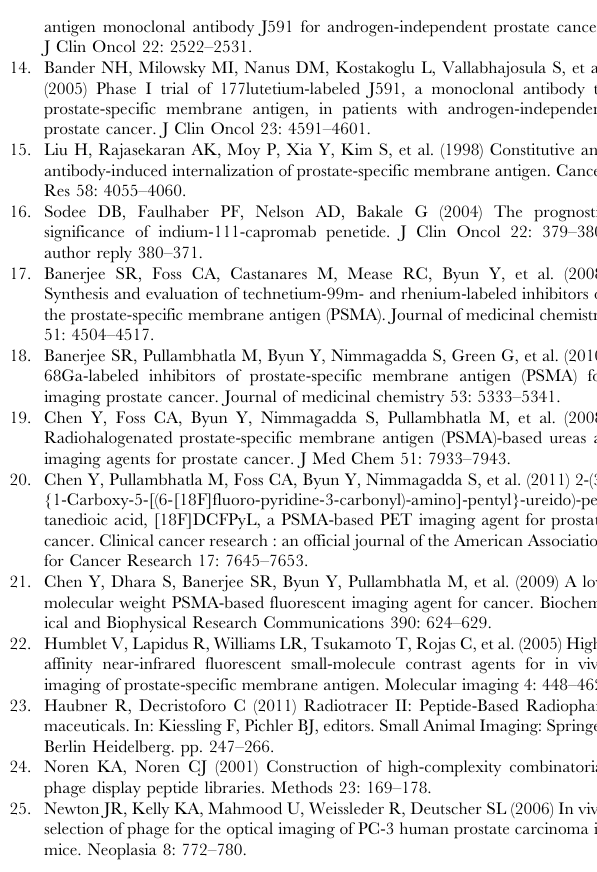
Table S1 DNA sequences of PSMA-targeted